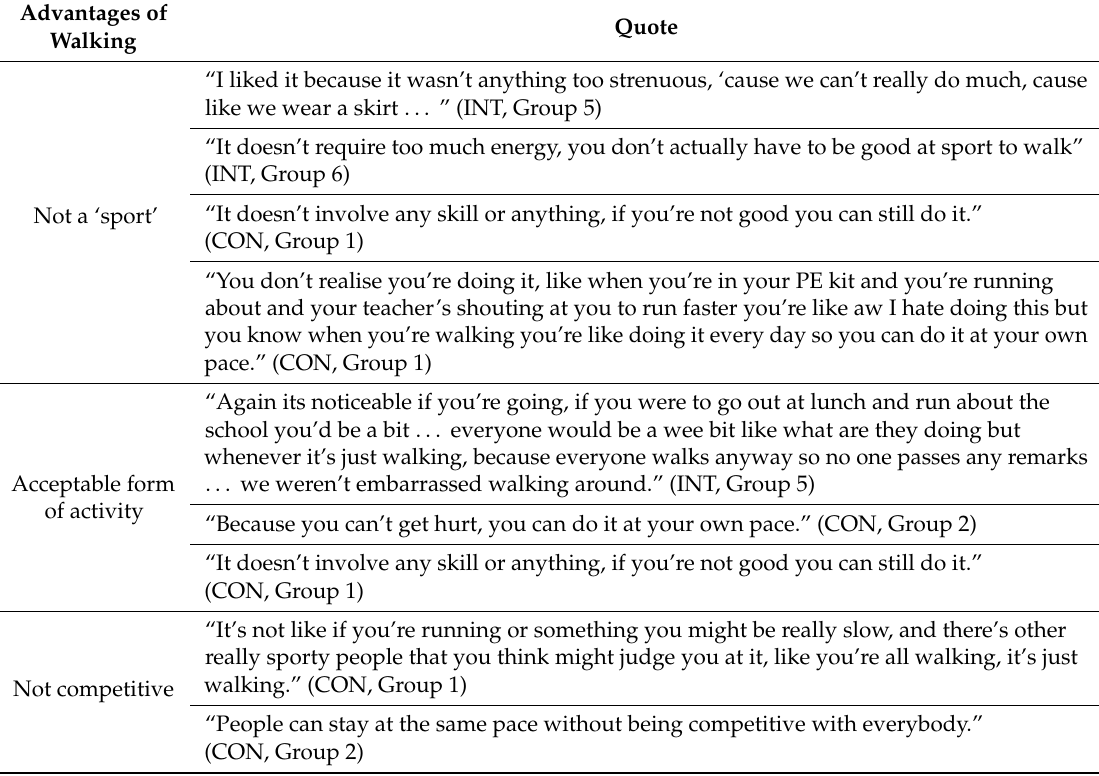
Table 2. Advantages of walking from thematic